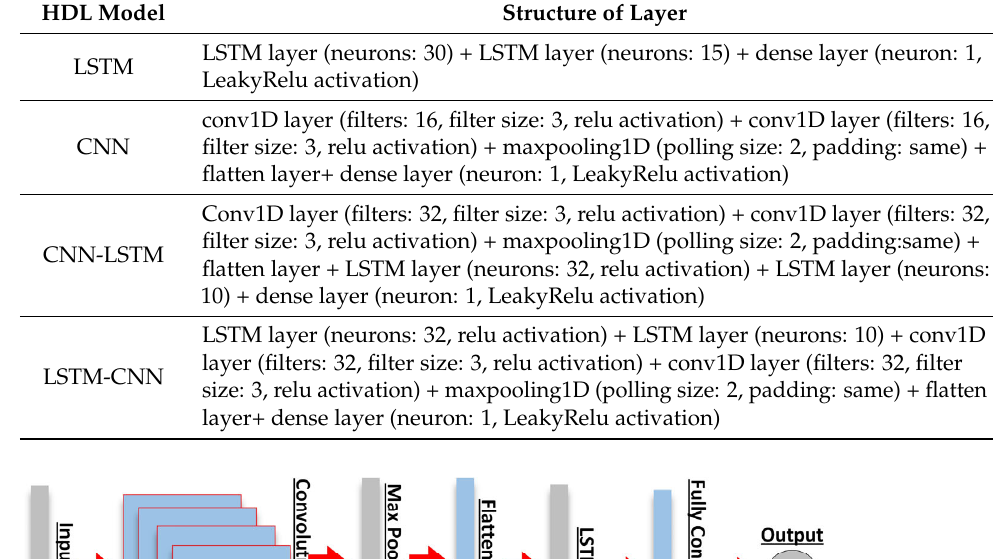
Table 2. Hybrid deep learning model structure.